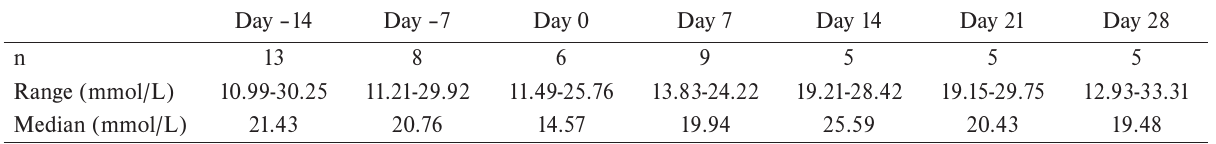
Table 4. Blood glucose levels in diabetic rabbits over